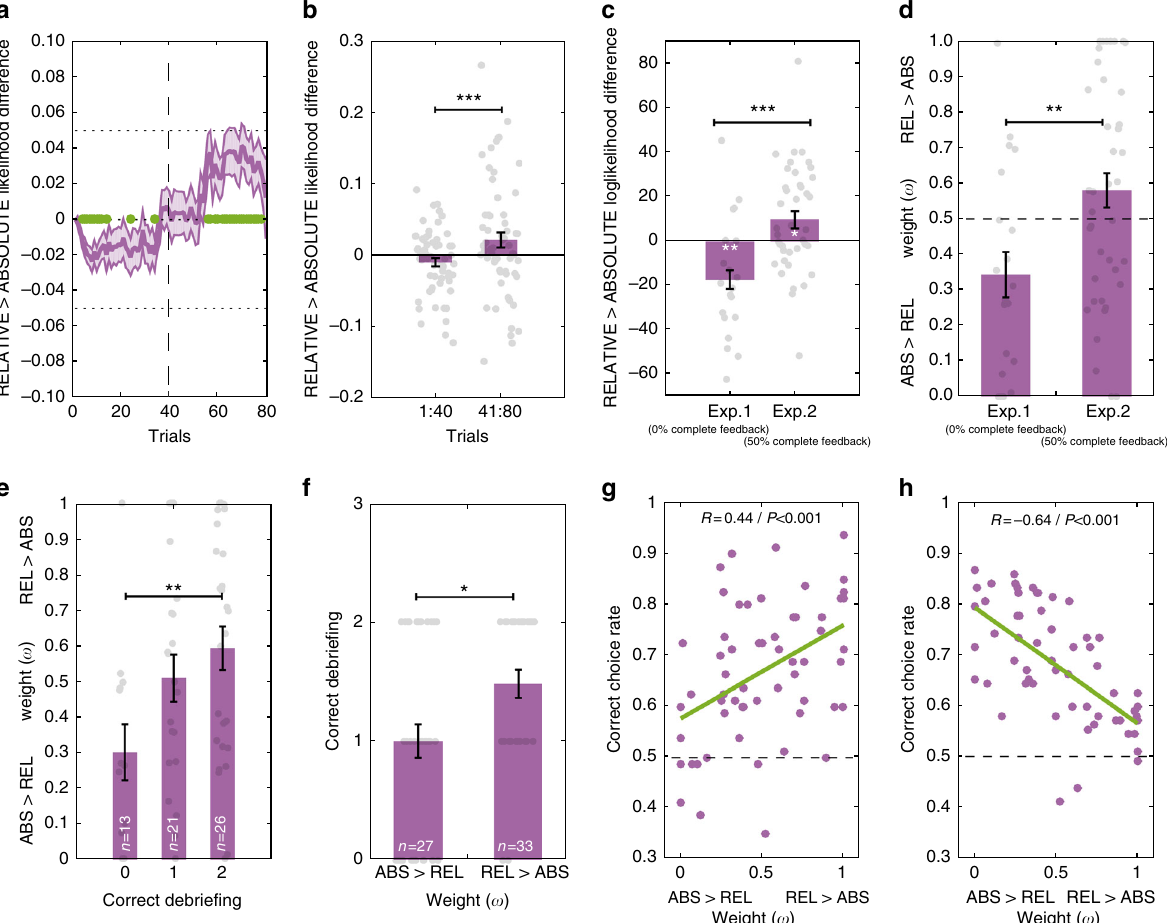
Fig. 4 Computational properties and behavioral correlates of value normalization. a Likelihood difference (from model fi tting) between the RELATIVE and the ABSOLUTE models over the 80 trials of the task sessions for both experiments ( N = 60). A negative likelihood difference means that the ABSOLUTE model is the best- fi tting model for the trial and a positive likelihood difference means that the RELATIVE model is the best- fi tting model for the trial. Green dots: likelihood difference signi fi cantly different from 0 ( P < 0.05, t -test). b Likelihood difference between the RELATIVE and the ABSOLUTE models over the fi rst part of the task (40 fi rst trials) and the last part (40 last trials) for both experiments. c Likelihood difference between the RELATIVE and the ABSOLUTE models for the two experiments. A negative likelihood difference means that the ABSOLUTE model is the best- fi tting model for the experiment and a positive likelihood difference means that the RELATIVE model is the best- fi tting model for the experiment. d Subject-speci fi c free parameter weight ( ω ) comparison for the two experiments. e Subject-speci fi c free parameter weight ( ω ) as a function of correct debrie fi ng for the two questions ( “ fi xed pairs ” and “ number of pairs ” ). f Debrie fi ng as a function of the weight parameter. Small light gray dots above and below the bars in a – f represent individual subjects ( N = 60). g and h Correct choice rate as a function of subjects ’ weight parameter in the learning sessions and the transfer test for both Experiments 1 and 2. One dot corresponds to one participant ( N = 60); green lines represent the linear regression calculations. Error bars represent s.e.m. *** P < 0.001, ** P < 0.01, * P < 0.05, t